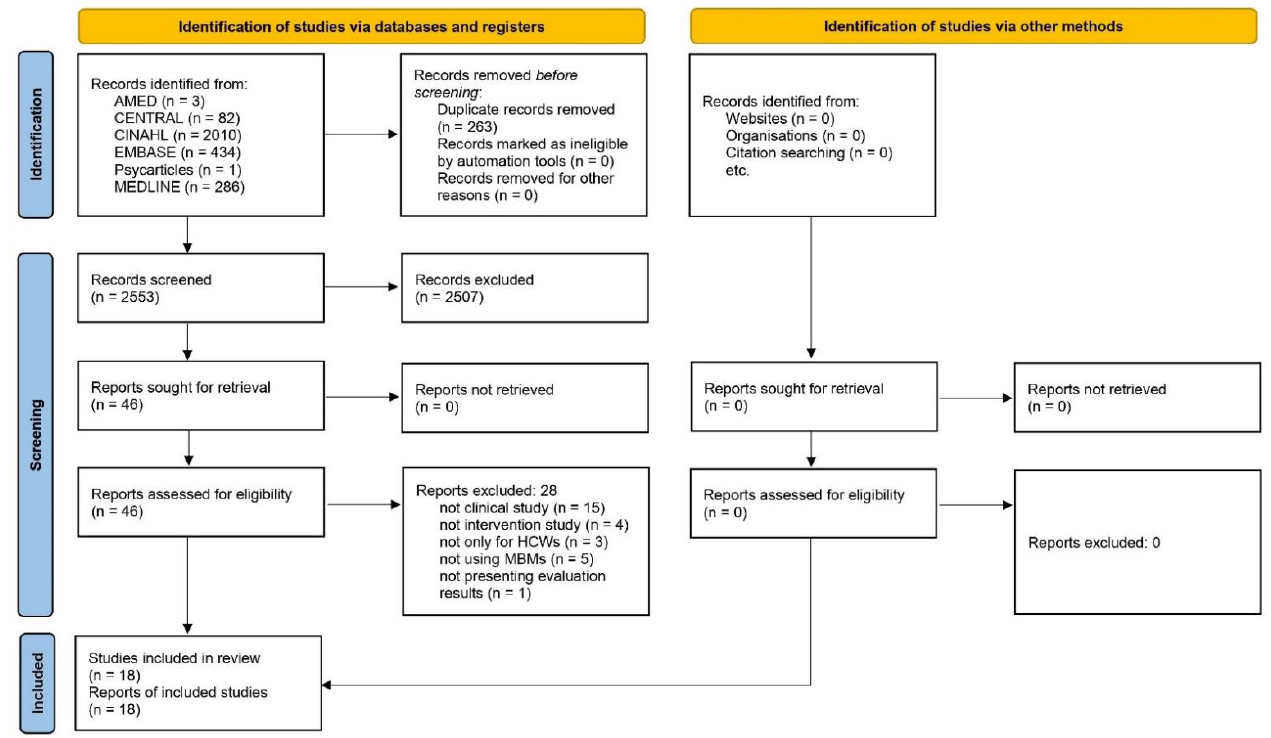
Figure 1. PRISMA flow chart of this review.